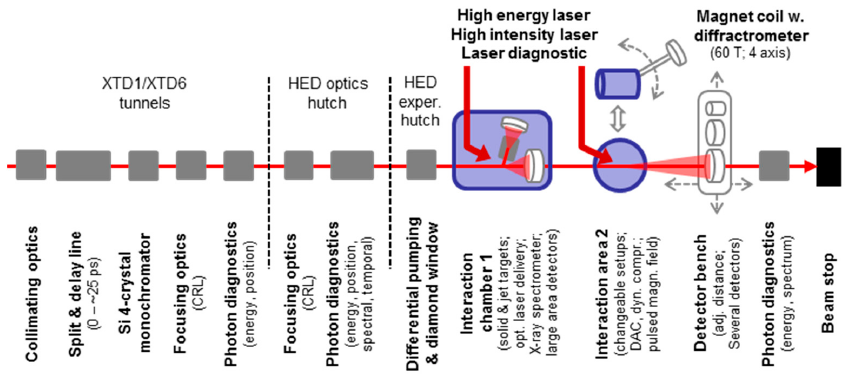
Figure 9. Schematic outline of the HED scientific instrument at the SASE2 FEL beamline. Shown are major instrumentation items installed in the photon beam transport tunnel, optics hutch and experiment hutch comprising the beam transport, focusing and diagnostic devices as well as the large optical lasers, second interaction area instrumentation and detectors contributed by the HiBEF User Consortium.